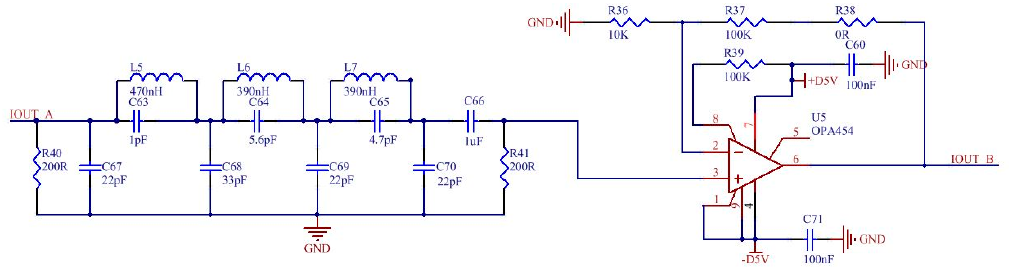
Figure 12. Filter and amplification circuit design.